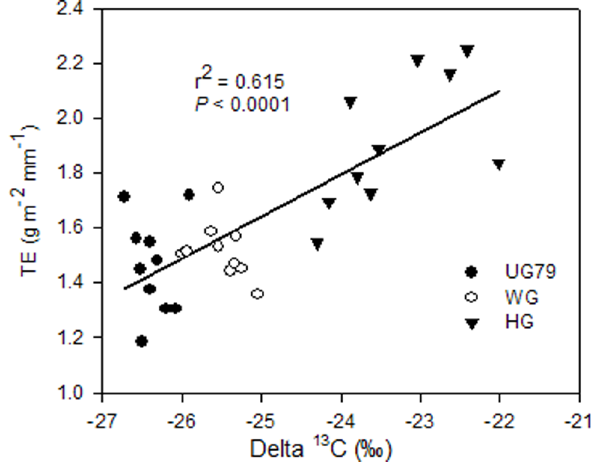
Figure 7. Correlation between transpiration efficiency and carbon stable isotope discrimination. The data were from the vegetation growth period of 2005 at three differently managed sites. Same symbols as in Figure